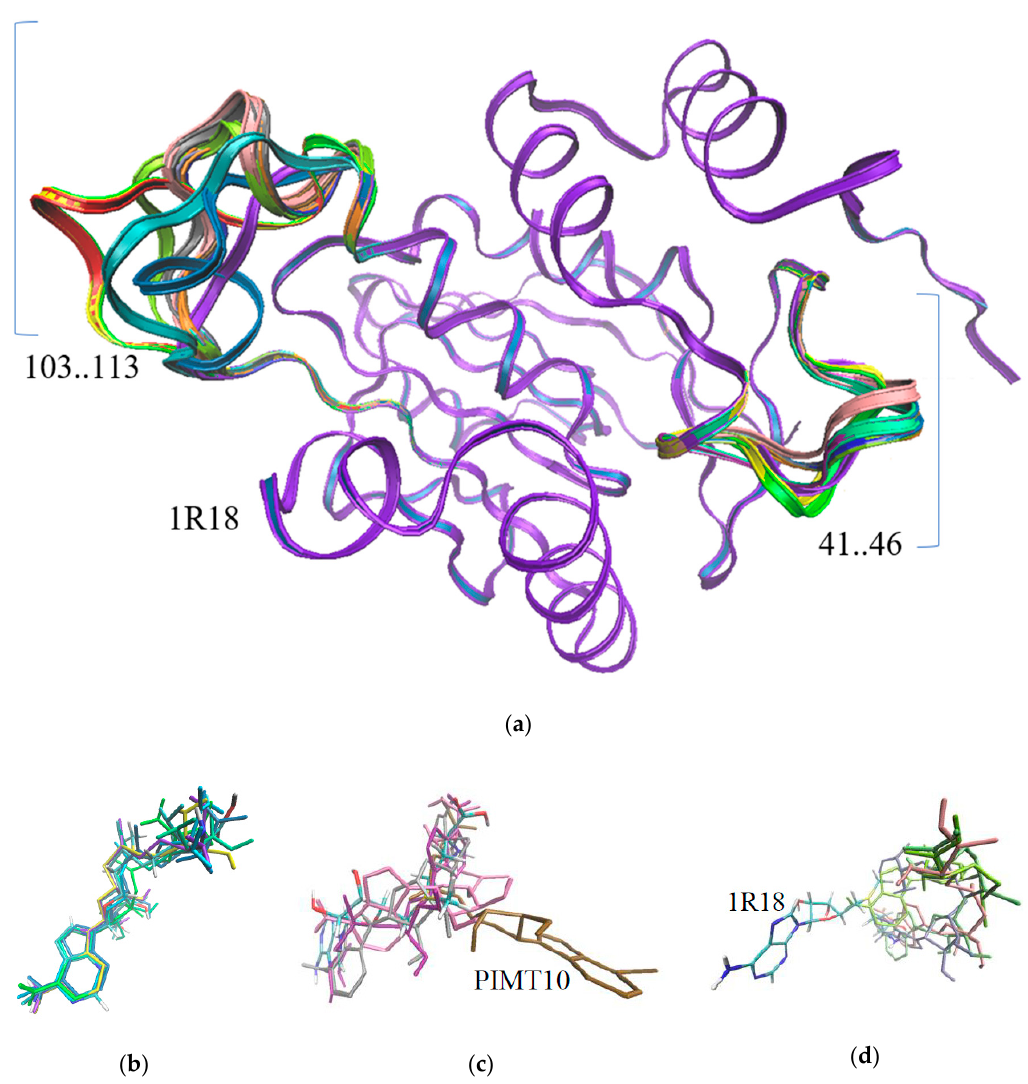
Figure 3. Modeling of PIMT spatial structures and docking with SAM; ( a ) predicted models of PIMTs using 1R18 as reference and position of SAM in di ff erent PIMTs of P. vanderplanki ; ( b ) orientation of SAM similar to 1R18 in PIMT 1, 2, 5, 11, 12, and 14; ( c ) positions of SAM in PIMT 3, 6, 9, and 10; ( d ) di ff erent orientations of SAM in PIMT 4, 7, 8, and 13.